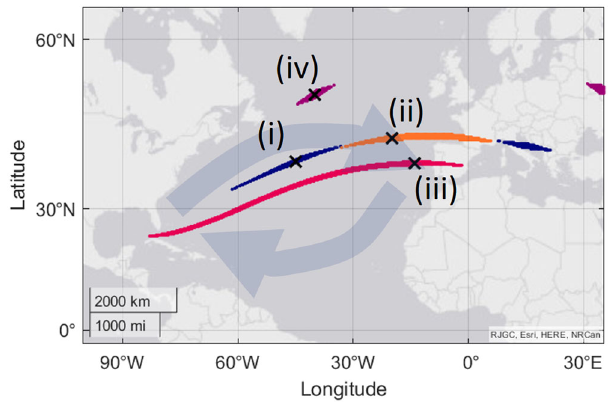
Fig. 4 Possible locations for the virtual magnetic displacements in ref. 18 . Coloured areas show all possible locations with the same magnetic parameters as those used in the study. A different colour is used for each virtual magnetic displacement (i – iv). The large faded arrows indicate the fl ow direction of the Atlantic